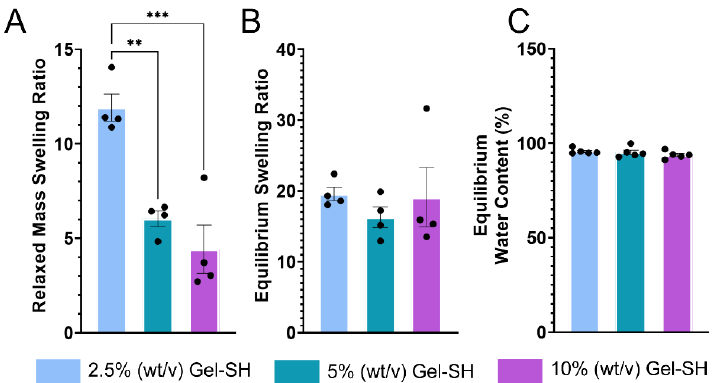
Figure 6. Swelling properties of Gel-SH/PEG-4MAL hydrogels. ( A ) Relaxed hydrogel swelling ratio ( Q mr ) describes the relationship between the weight of the dried hydrogel and weight of the hydrogel immediately after crosslinking. ( B ) Equilibrium swelling ratio ( Q m ) describes the relationship between the weight of the dried hydrogel and weight of the hydrogel after swelling. ( C ) Equilibrium water content ( EWC ) describes the capacity for the hydrogel to retain water when osmotic and ionic pressure of solutions external to the hydrogel matrix are at equilibrium with the pressure of the hydrogel matrix. ( n ≤ 4; mean ± SEM; significance testing = one-way ANOVA; ** = p ≤ 0.001, *** = p ≤ 0.0001). As seen in Figure 6, Gel-SH/PEG-4MAL Q mr decreased as hydrogel concentration decreased. This was to be expected, as Q mr is dependent on the weight of the